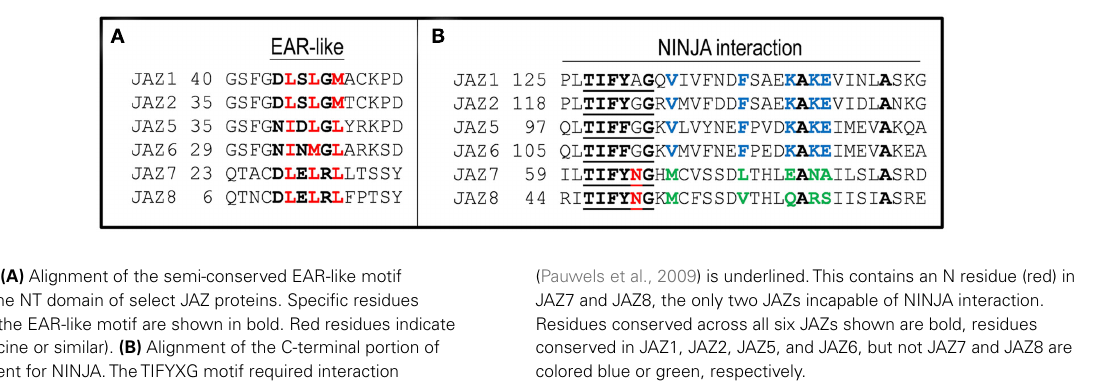
(Pauwels et al., 2009) is underlined.This contains an N residue (red) in JAZ7 and JAZ8, the only two JAZs incapable of NINJA interaction. Residues conserved across all six JAZs shown are bold, residues conserved in JAZ1, JAZ2, JAZ5, and JAZ6, but not JAZ7 and JAZ8 are colored blue or green,